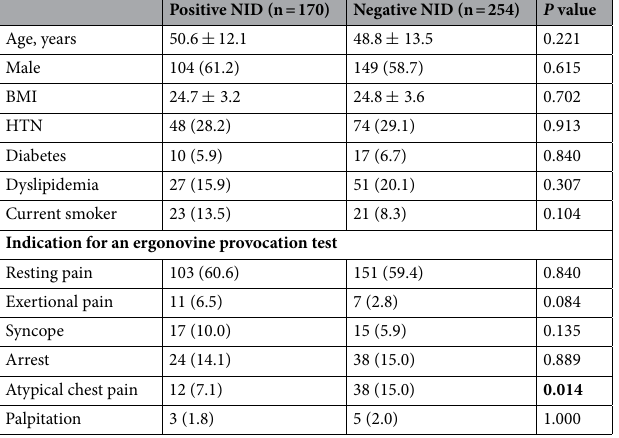
Table 2. Baseline characteristics and indications for an ergonovine provocation test between positive and negative NID groups. Data are expressed as number (percentages) or mean ± standard deviation. Abbreviations: NID nitroglycerin induced dilation, BMI body mass index, HTN hypertension. Significant values are in